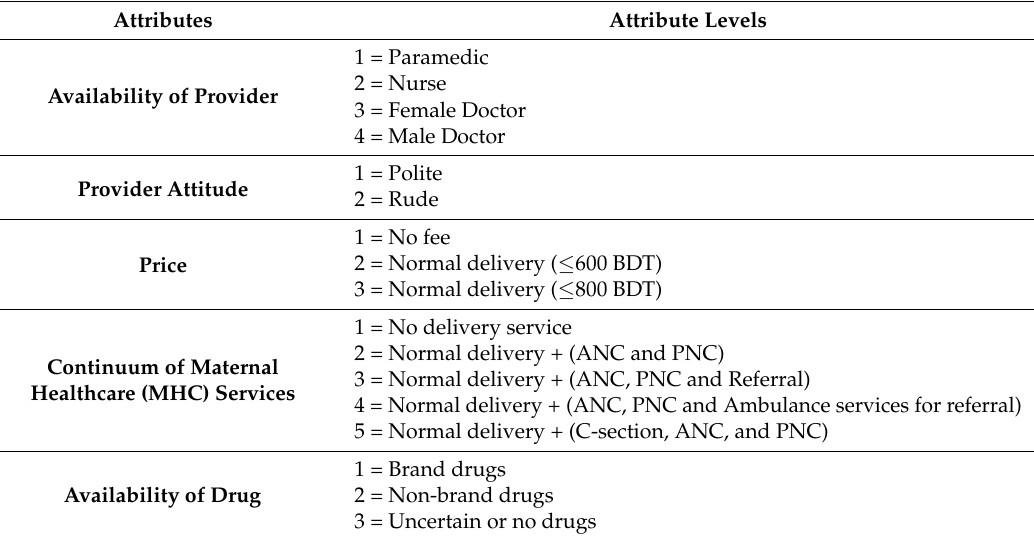
Table 1. The attributes of maternal healthcare